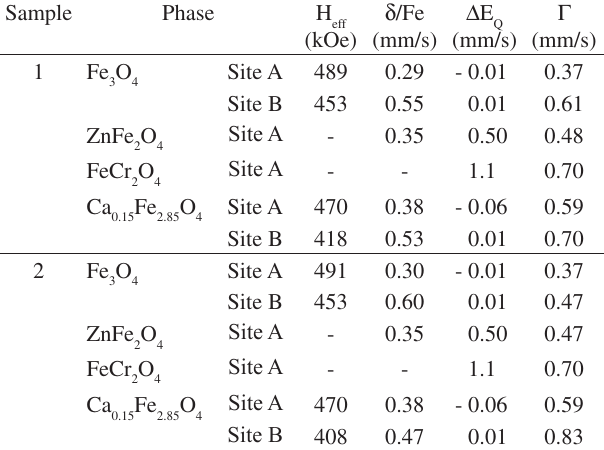
Table 5. Möss�a�er Parameters* �sed i� the spectra fit o� the EAFD samples at room temperat�re.